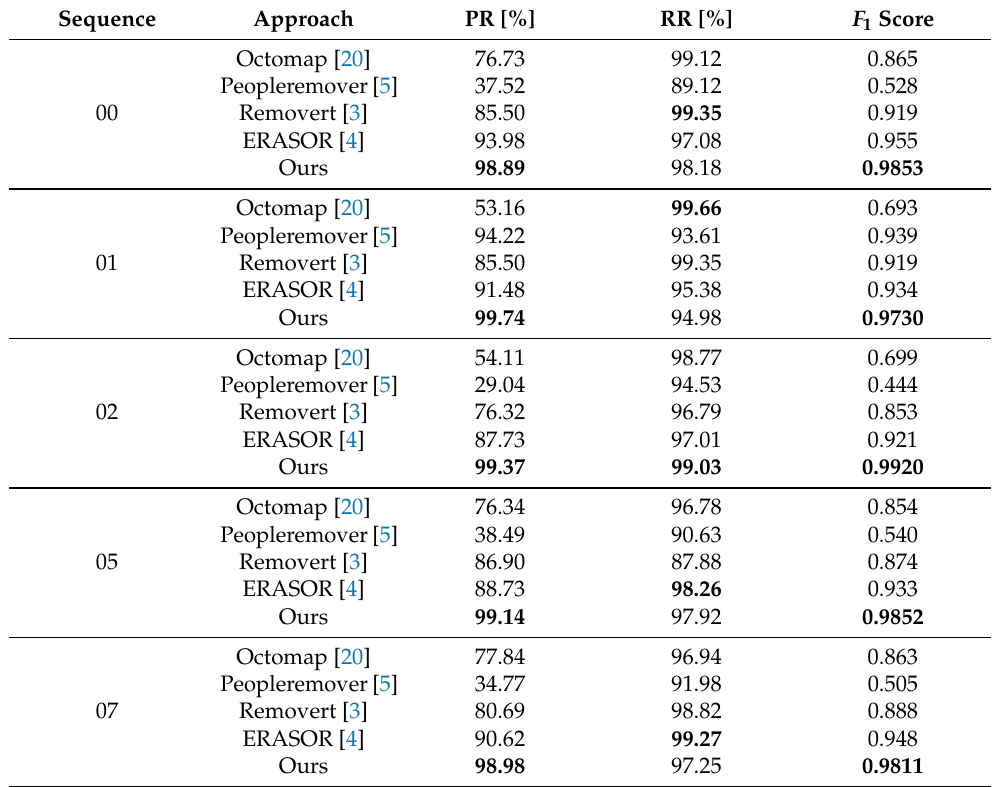
Table 2. Map cleaning results on the SemanticKITTI dataset. The best results are colored in bold.